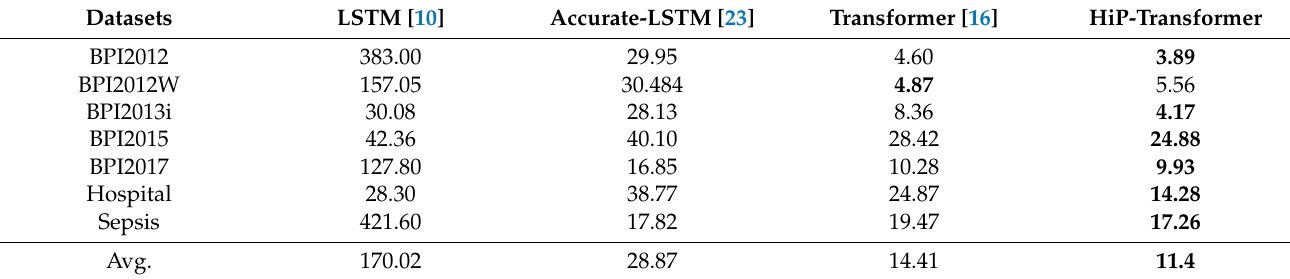
Table 3. Remaining execution time prediction effect (MAE: